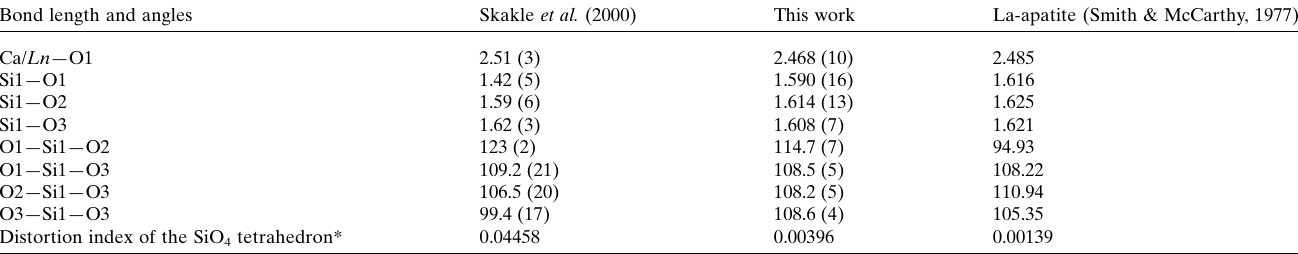
Table 1 Selected bond lengths (A˚ ) and angles ( (cid:4) ) in the redetermined structure and the already published Ce apatite structure (Skakle et al. , 2000) and Ca 2 La 8 (SiO 4 ) 6 O 2 .